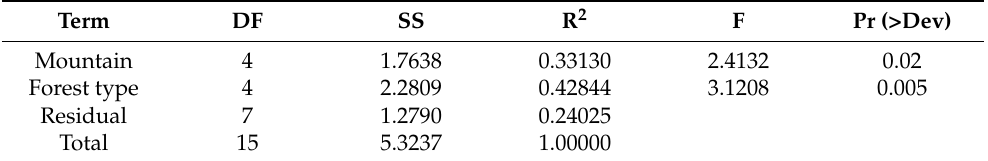
Table 3. PERMANOVA table from the analysis of the beta-diversity turnover component testing the influence of mountain and forest types across elevation. Significance level at p <